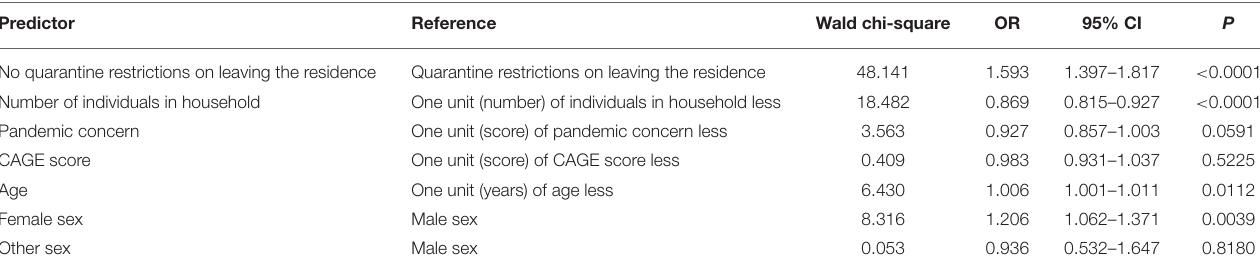
TABLE 1 | Predictors of change in alcohol consumption during the early COVID-19 pandemic. Predictor